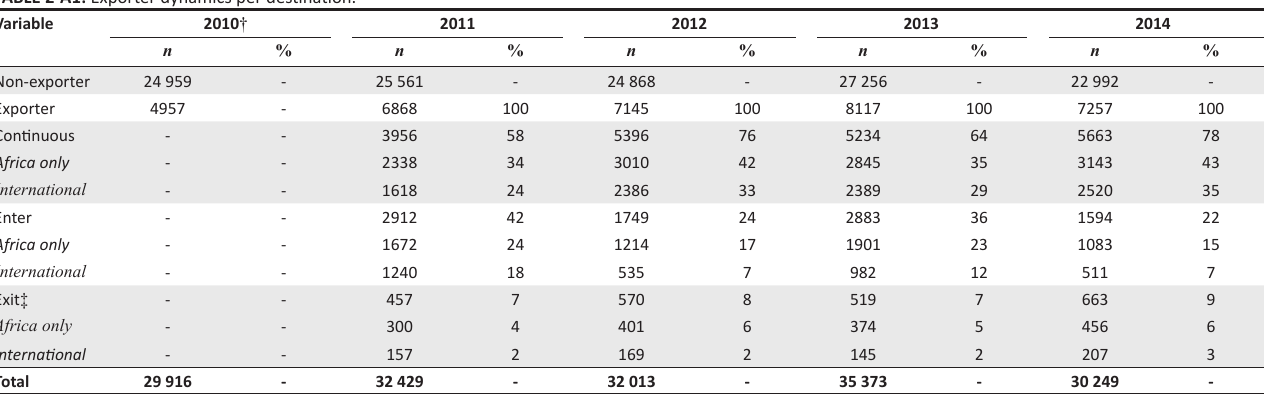
TABLE 2-A1: Exporter dynamics per